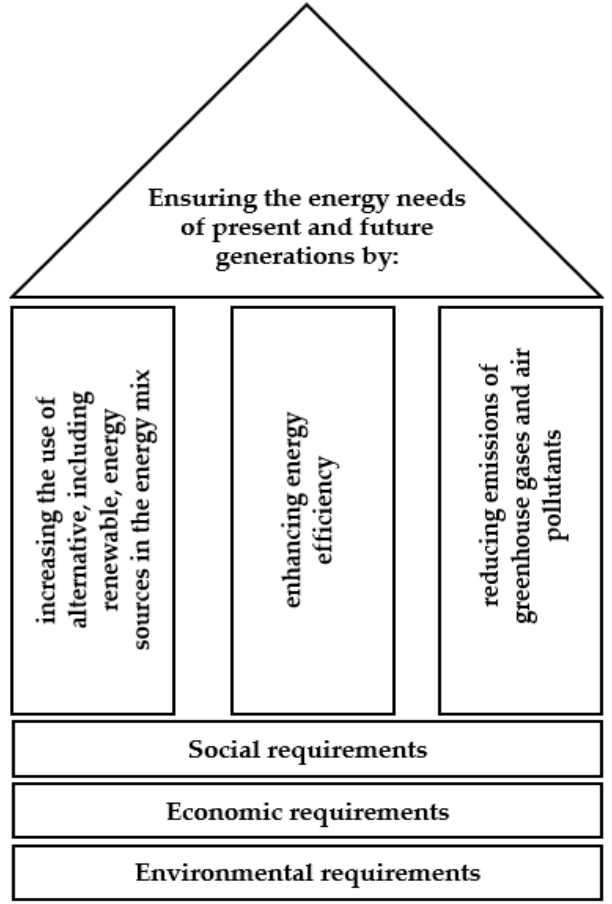
Figure 4. Graphical interpretation of the SED concept. Source: own study.